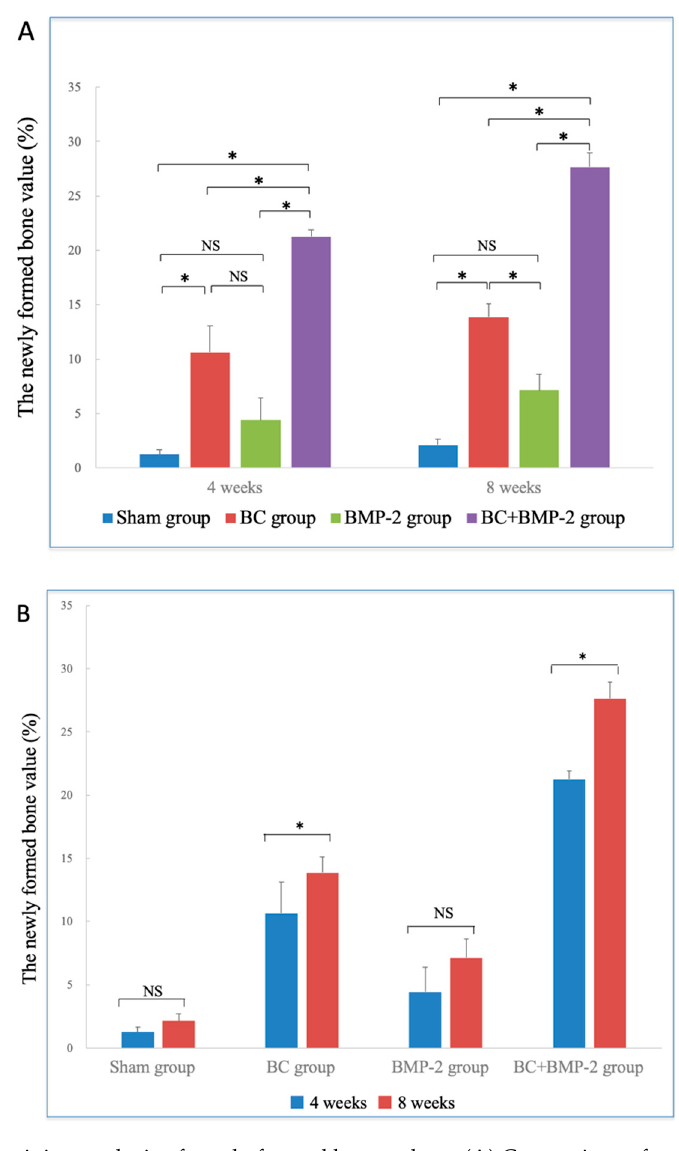
Figure 4. H&E staining analysis of newly formed bone values: ( A ) Comparison of newly formed bone values between different groups, analyzed by One-way analysis of variance and LSD- t test. * p < 0.05; NS: no significance. Error bars indicate standard deviations. ( B ) Comparison of newly formed bone values between four and eight weeks, analyzed by independent-samples t -test; * p < 0.05; NS: no significance. Error bars indicate standard deviations.